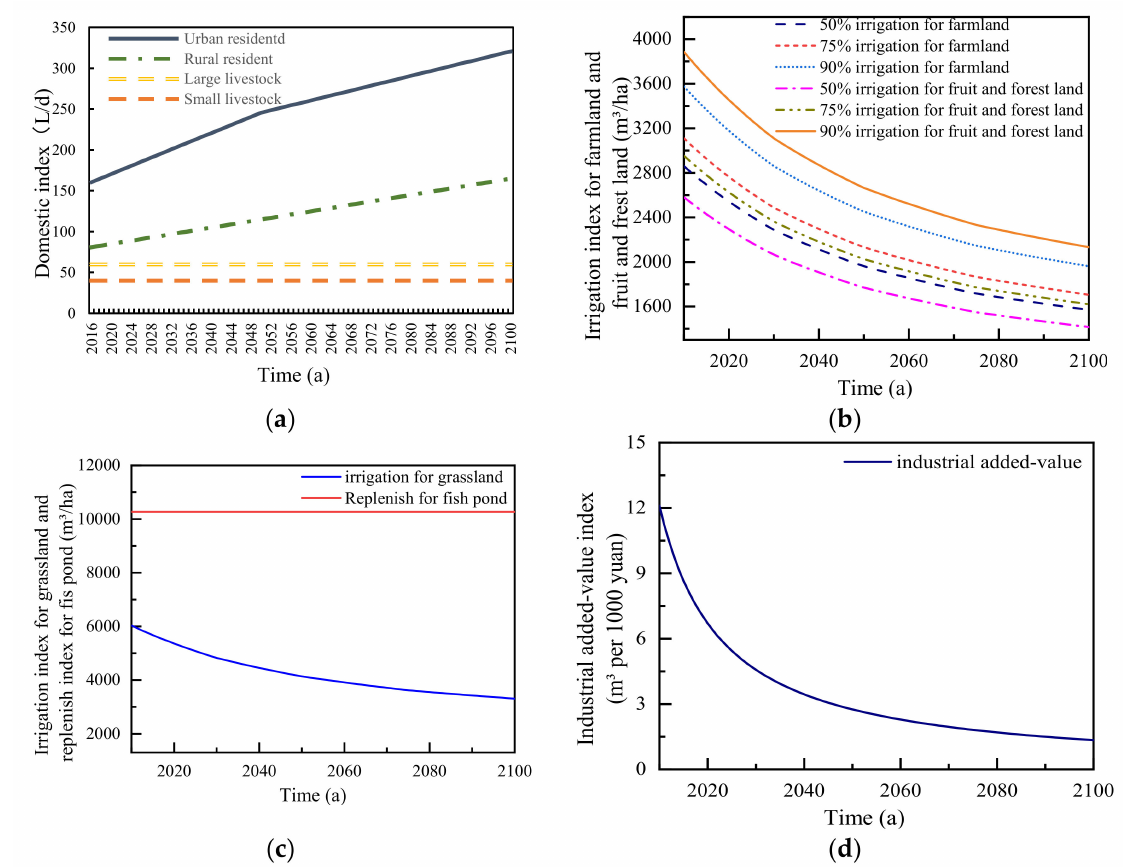
Figure 14. Forecasting of water use indices: domestic ( a ), agricultural forestry and pastoral and fishery irriga- tion/replenishment ( b , c ), and industrial ( d ).